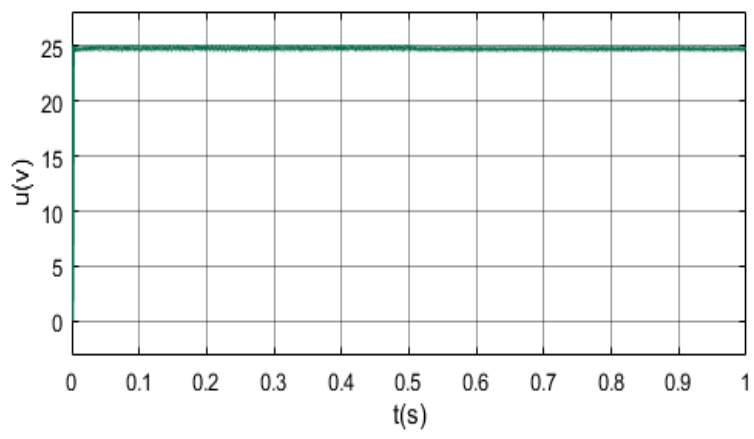
Figure 13. Output voltage waveform.